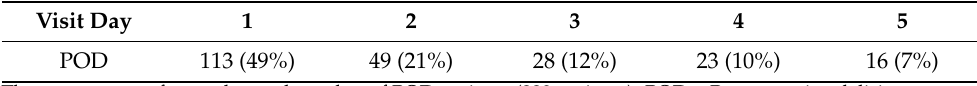
Table 2. Prevalence of first delirium occurrence per visit